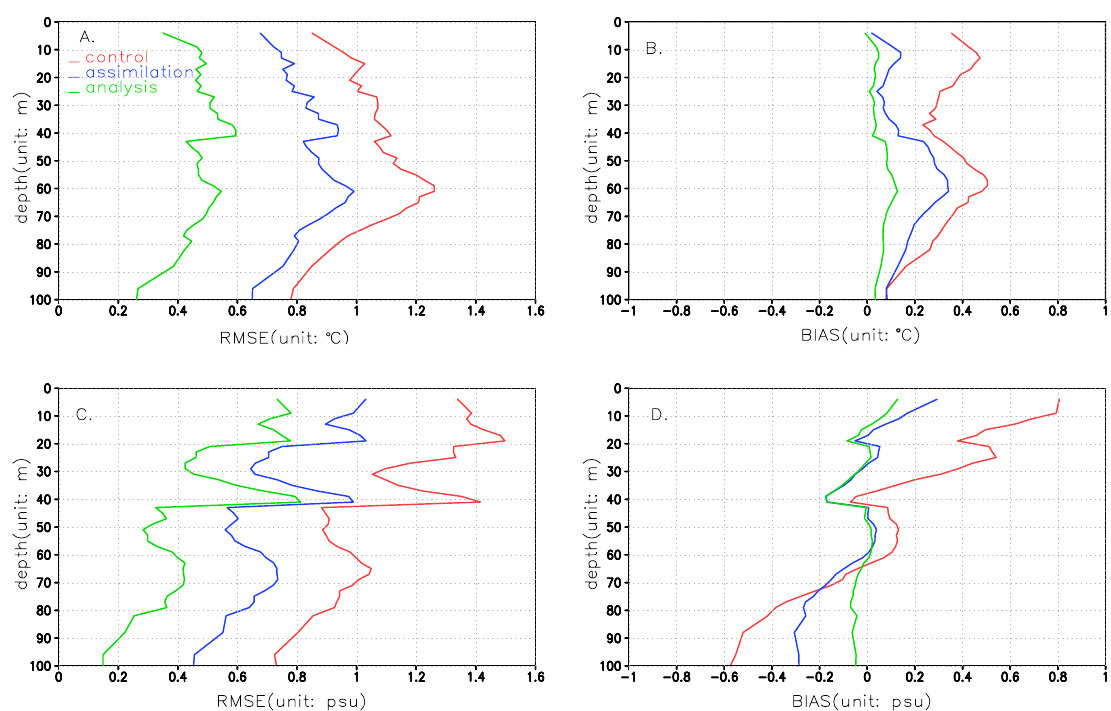
Fig. 9. The comparison of rmse and bias profiles for both temperature (A, B) and salinity (C, D) among the innovation from control experiment (red line), the innovation from 3DVAR assimilation experiment (blue line), and the analysis residual from 3DVAR assimilation experiment(green line). The experiments run daily forecast through the year of